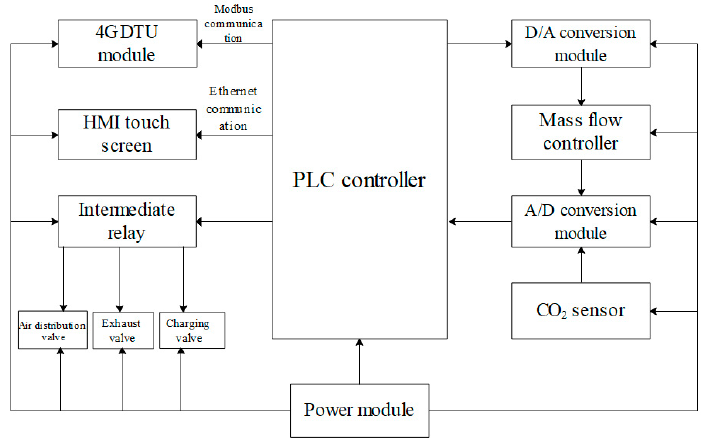
Figure 10. Hardware structure of the gas preservation and gas distribution system.